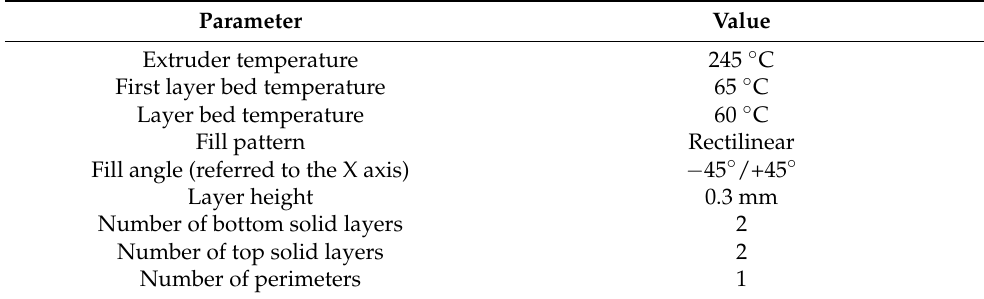
Table 1. Printing parameters established on Slic3r software.